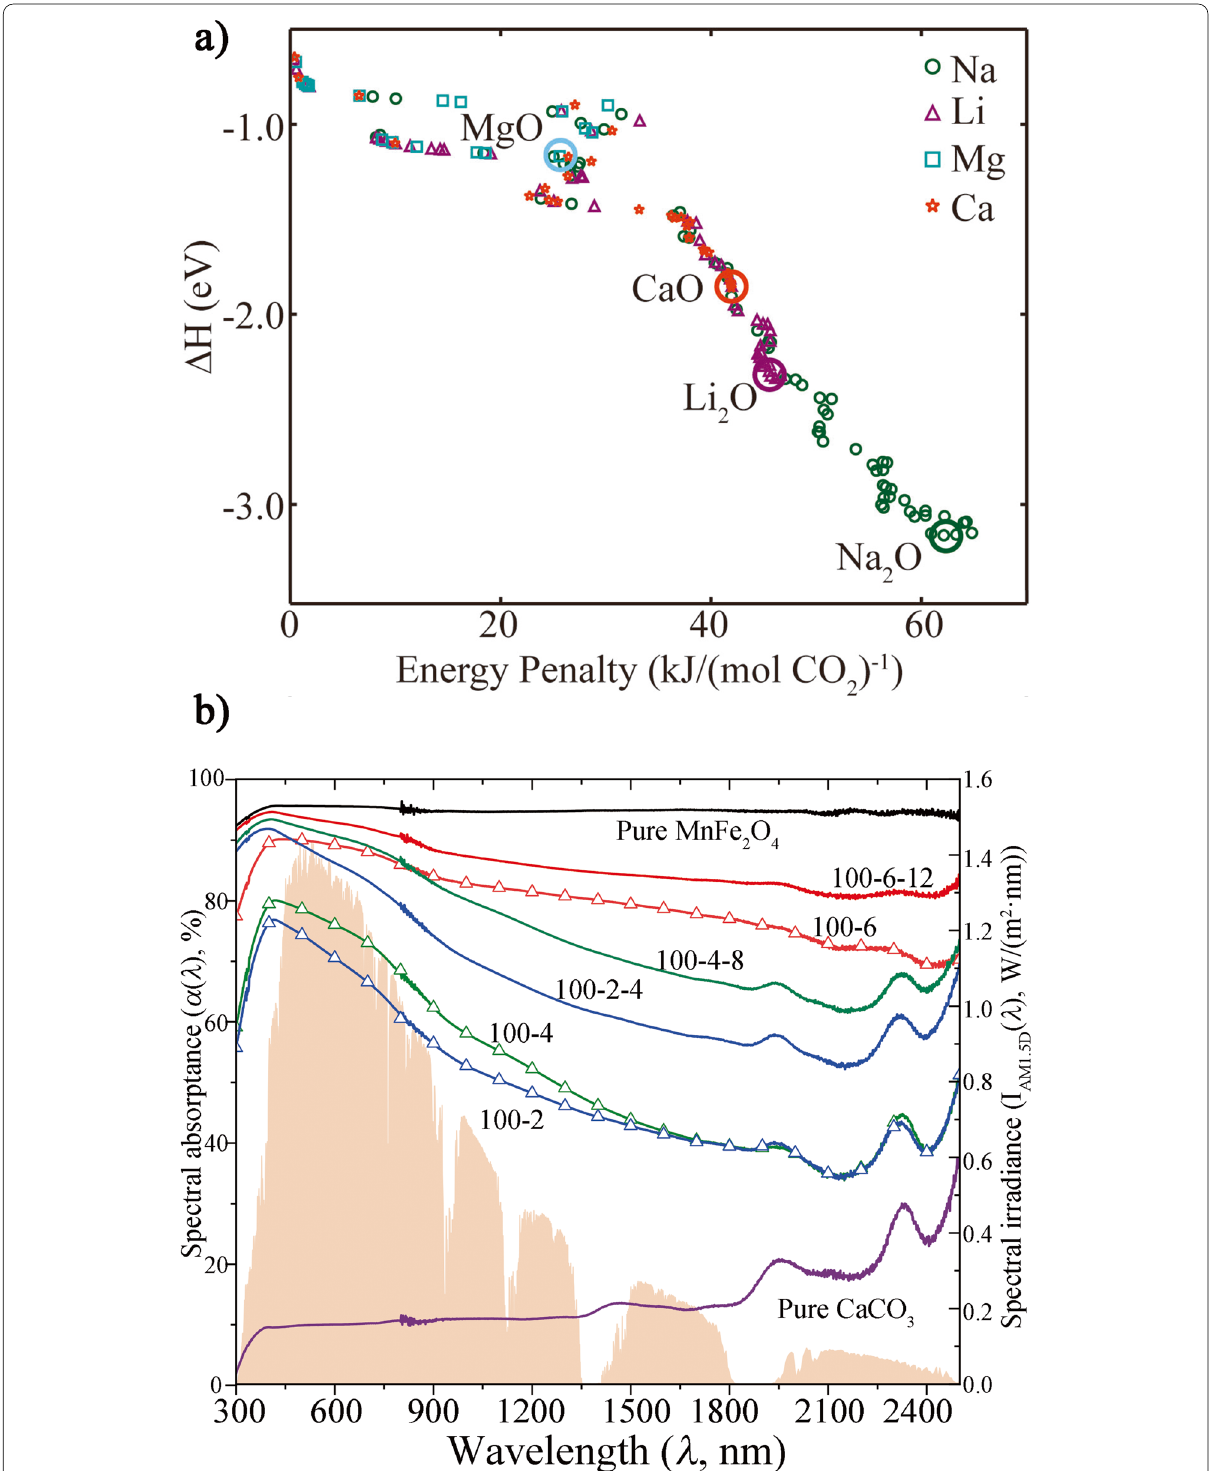
Fig. 16 a Screened materials containing Na, Li, Mg or Ca as their alkali atom: the calculated energy penalty, E p , for each reaction is plotted against ΔH, the respective binary oxides are cycled [95]; b Spectral absorptances of some composite materials